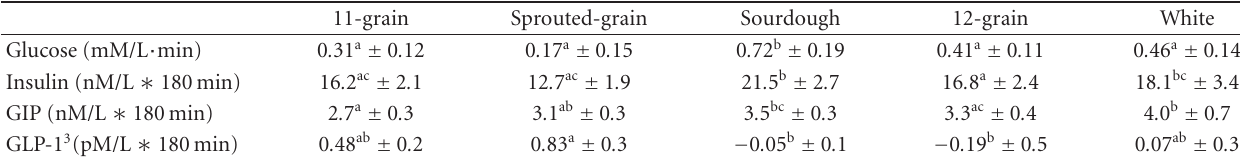
Table 4: Incremental area under the curve for blood glucose, serum insulin, plasma GIP and GLP-1 responses to the ingestion of set amount of the test breads for 180 min (part 2) 1,2 .